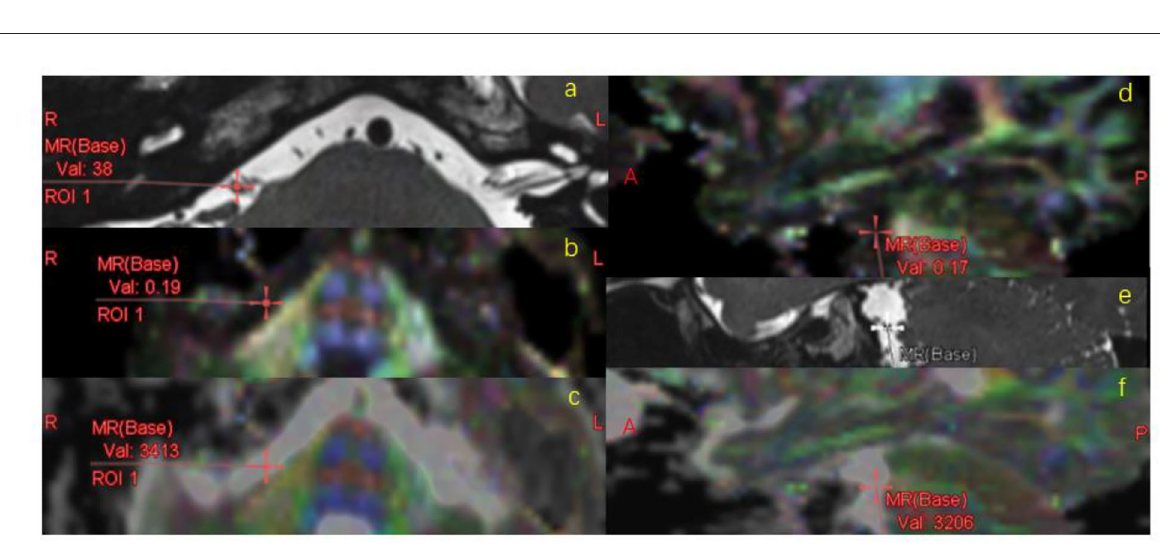
FIGURE2 FA/ADC measurement. VCN was located on the T2 map (a,e) , registered to FA (b,d) map and ADC map (c,f) automatically, measured on FA/ADC map in the MR axial (a–c) and sagittal (d–f)